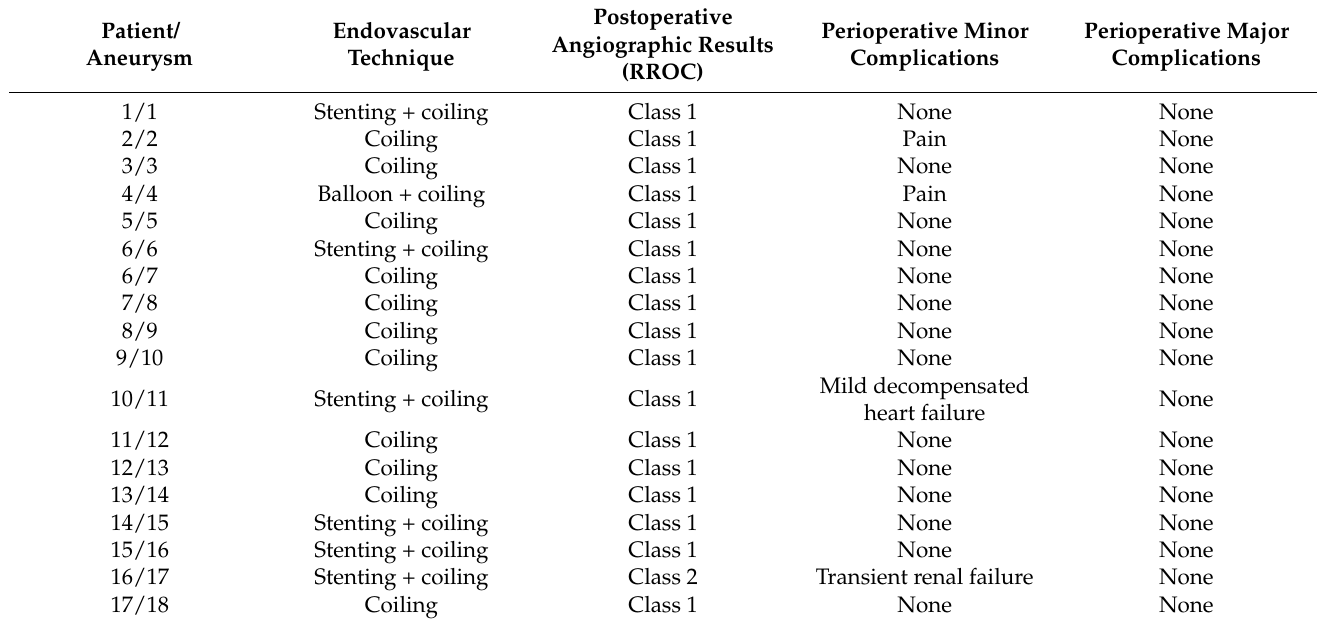
Table 3. Technique, angiographic results, and complications.